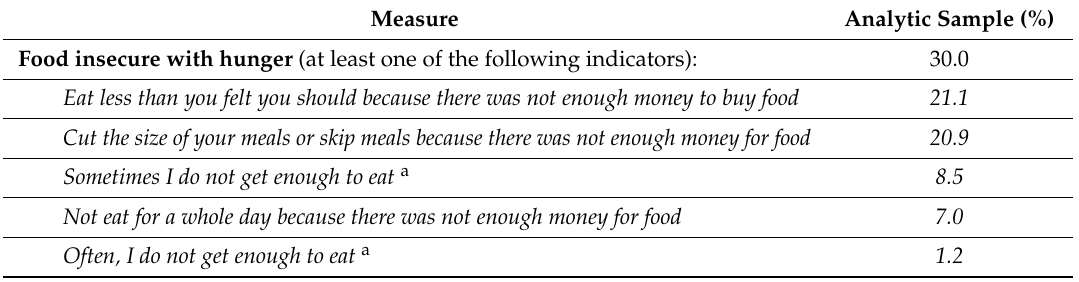
Table 2. Indicators of food insecurity with